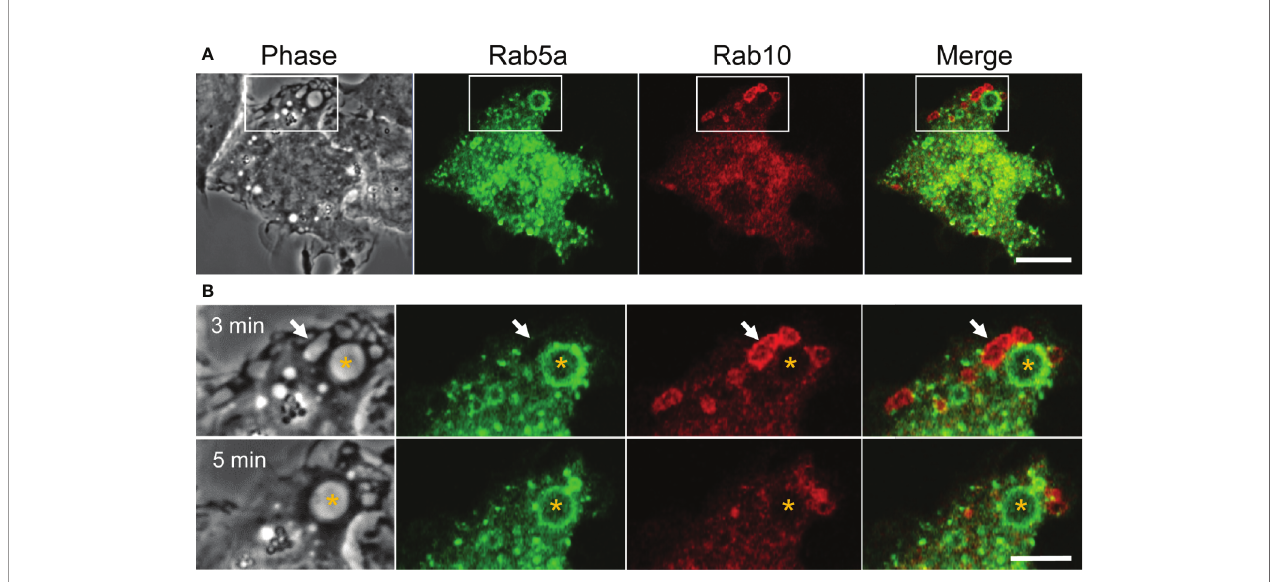
FIGURE 6 | Rab5, an early endocytic marker, is not recruited to Rab10-positive premacropinosomes and tubules. (A) Live-cell microscopy of RAW264 cells expressing EGFP-Rab5a and mCherry-Rab10. Scale bar = 10 m m. (B) Enlarged micrographs of the boxed area in (A) . Selective frames at two-time points as indicated. Rab5a-positive macropinosomes are Rab10-negative (asterisk). Rab10-positive compartments disappear within a few minutes without becoming Rab5a- positive, suggesting that Rab10-positive compartments are distinct from those of the classical macropinocytic pathway. Scale bar = 5 m m. The corresponding movie is available in the ( Supplementary Material Movie 9